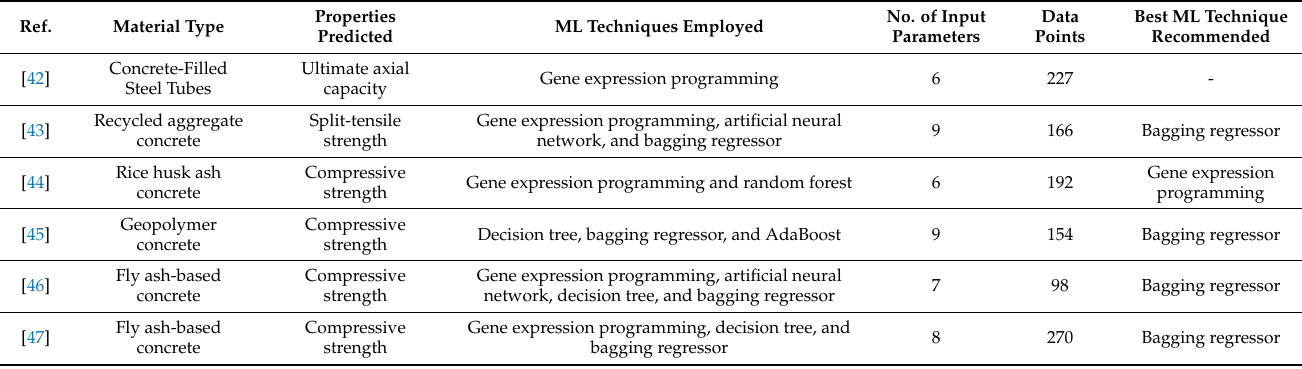
Table 2. ML techniques used in the previous